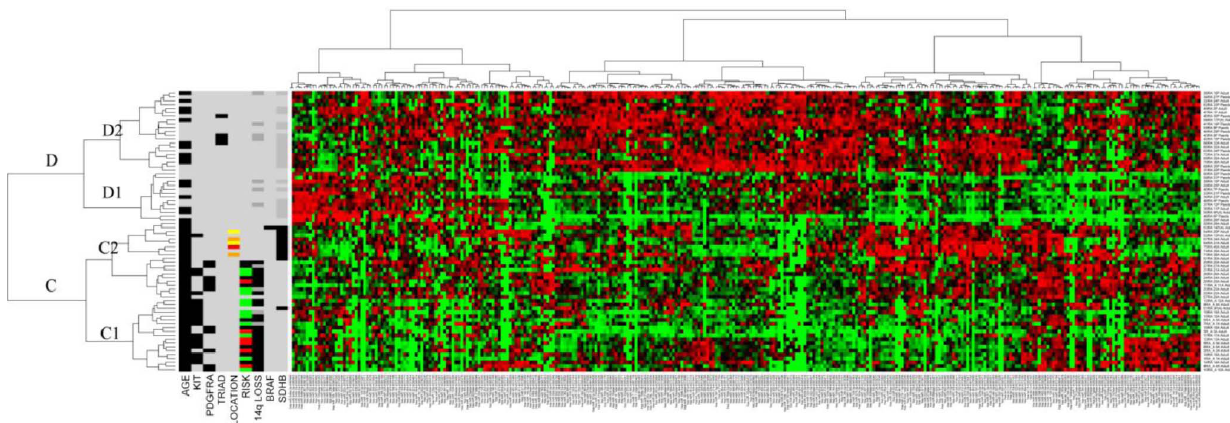
Figure 2. Heatmap minus dominant 14q miRNA expression. The clusters are designated C and D with sub-clusters C1, C2, D1 and D2 to facilitate discussion of findings. Case data as delineated for figure 1. Black=positive for feature listed. For age, black=adult, grey=pediatric; for KIT/ PDGFRA/BRAF black=mutation positive while grey=WT; Black=Carney triad diagnosed; for anatomic location of tumor, grey=stomach, red=retroperitoneum, yellow=jejunum; orange=ileum; for risk, red=low, black=intermediate, green=high, grey=unavailable. For 14q loss and SDHB-immunoreactivity status, black=positive; dark grey=tested and negative, grey=not tested. The clusters are designated A, B, with sub-clusters B1 and B2, B2a and B2b to facilitate discussion of findings.